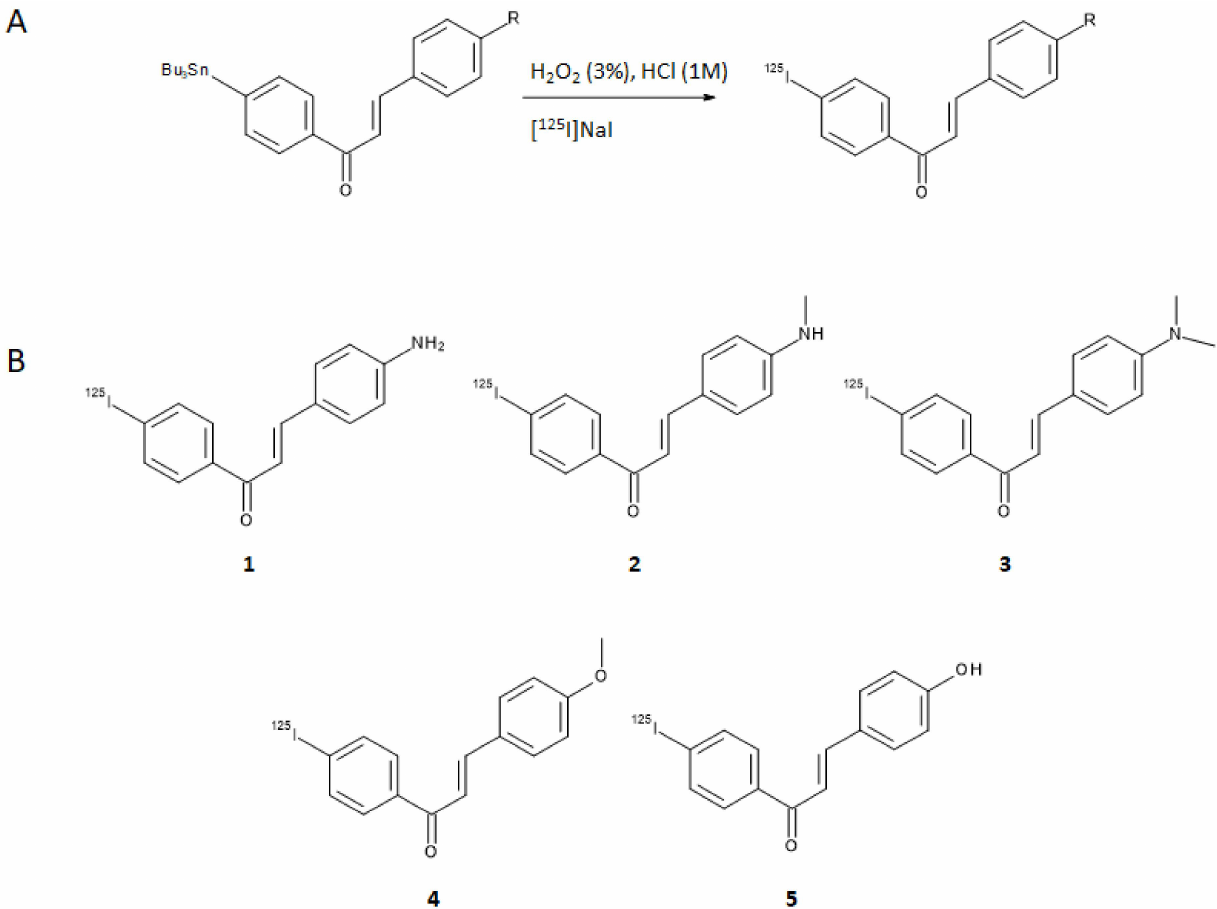
Figure 3. Synthetic pathway for the preparation of general [ 125 I]-labeled chalcone derivatives ( A ) and structures of all the derivatives explored in [19] ( B